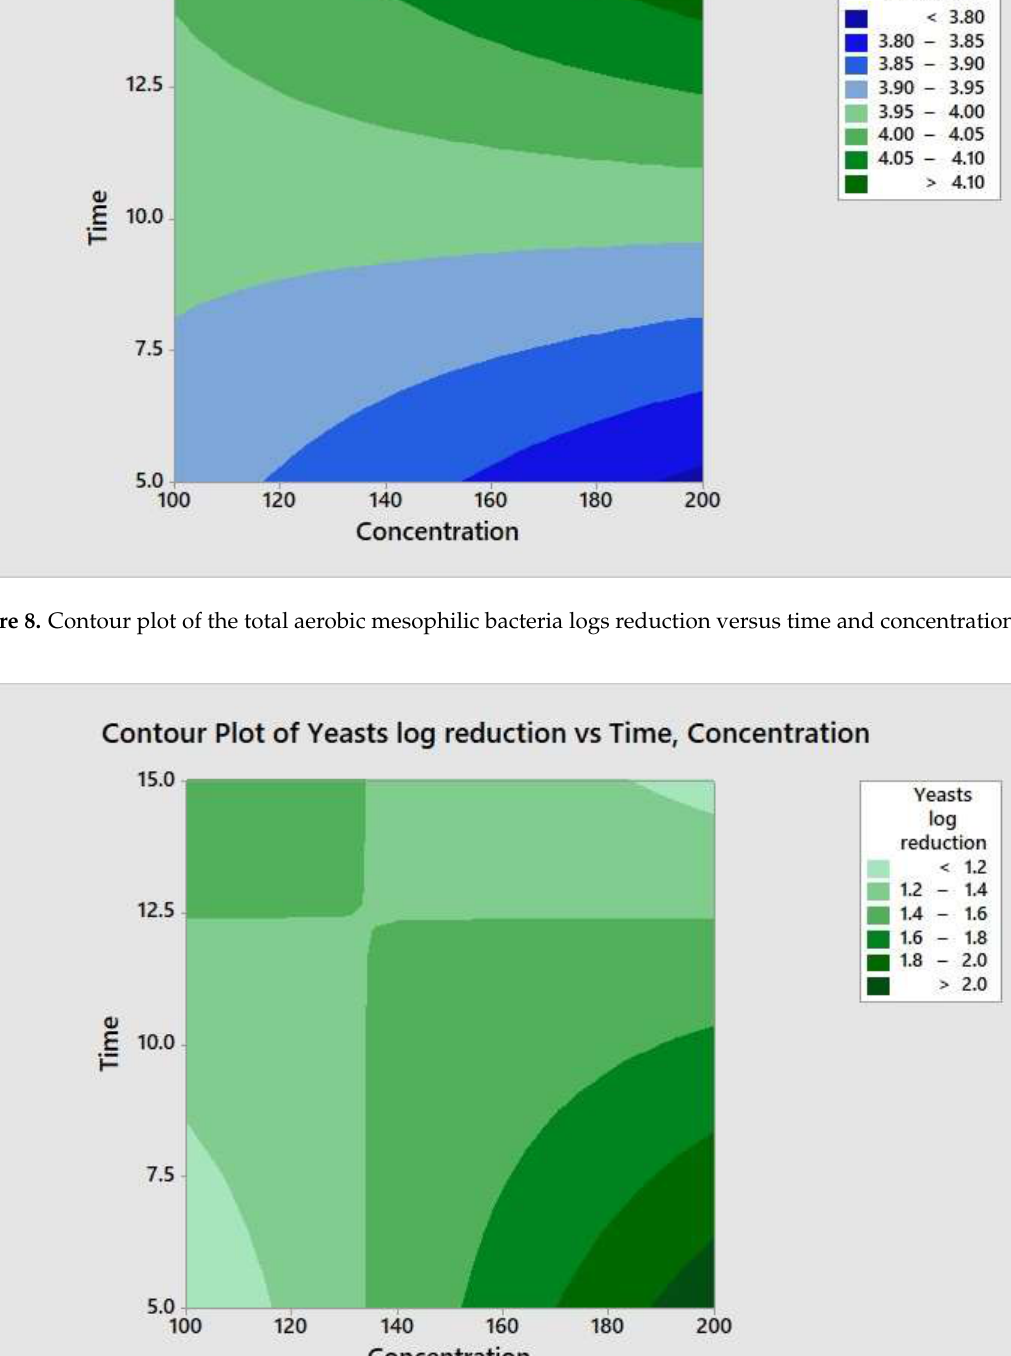
Figure 10. Contour plot of the molds logs reduction versus time and concentration. The two-way ANOVA analysis outcome postulates that a higher concentration of quat sanitizer and washing time might be needed to observe significant log reduction. In a study, Bernardi et al. [32] demonstrated that no differences in fungi reduction were ob- served when the quat sanitizer concentration doubled from 2.5% to 5%. In another study